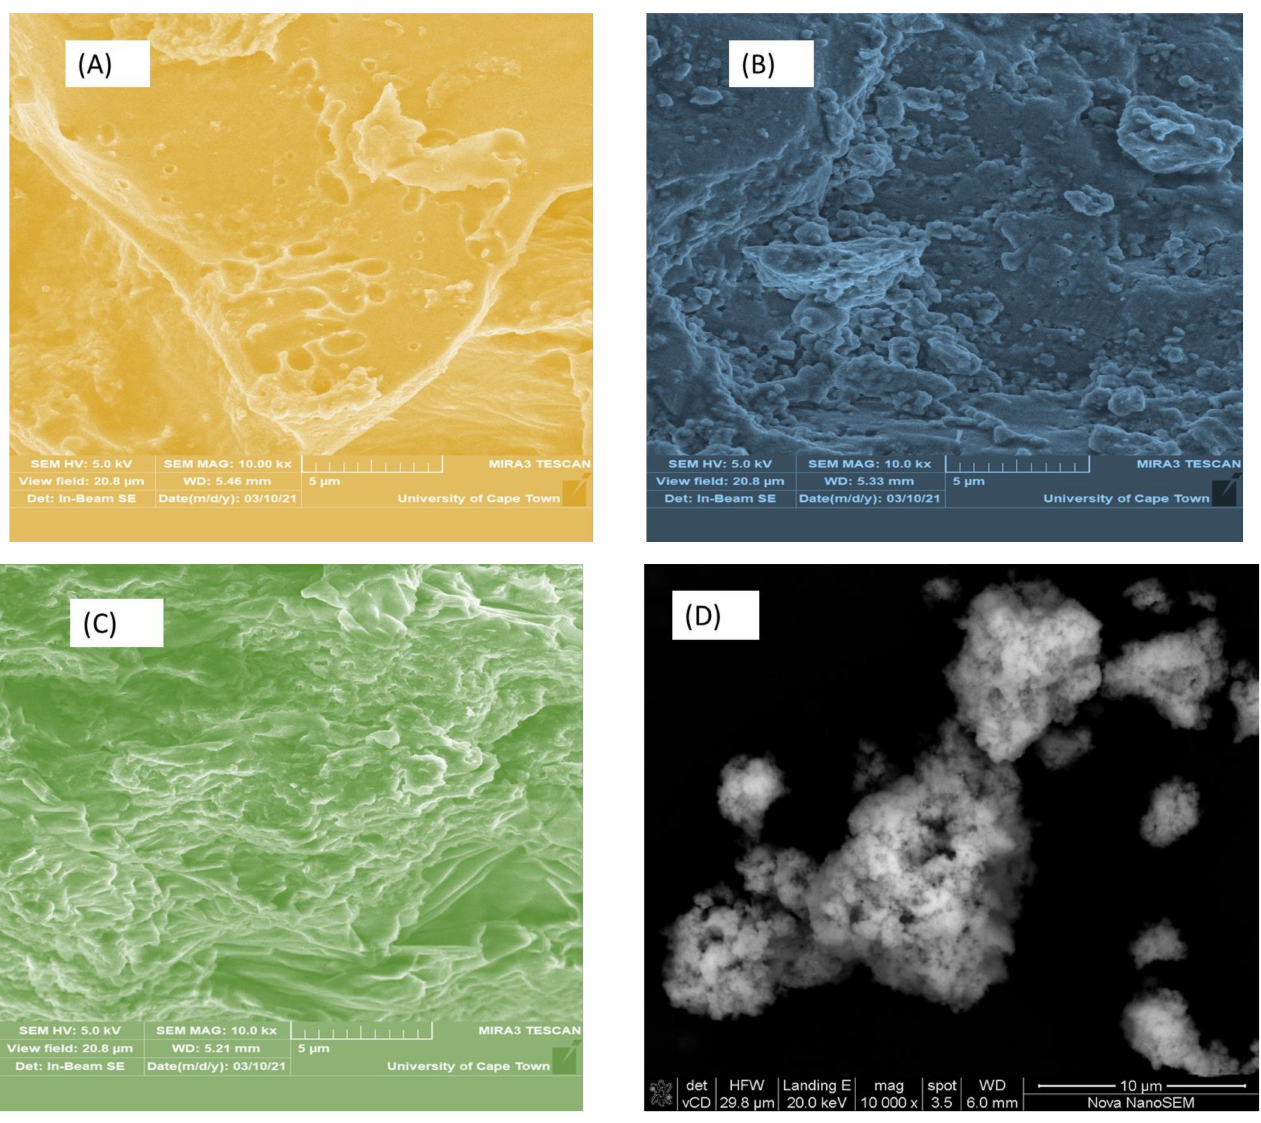
Figure 2. SEM images of biomaterials with view field of 20.8 µ m at high magnification of 10 kx; ( A ) BI, ( B ) CE, ( C ) PB and ( D ) Fe 3 O 4